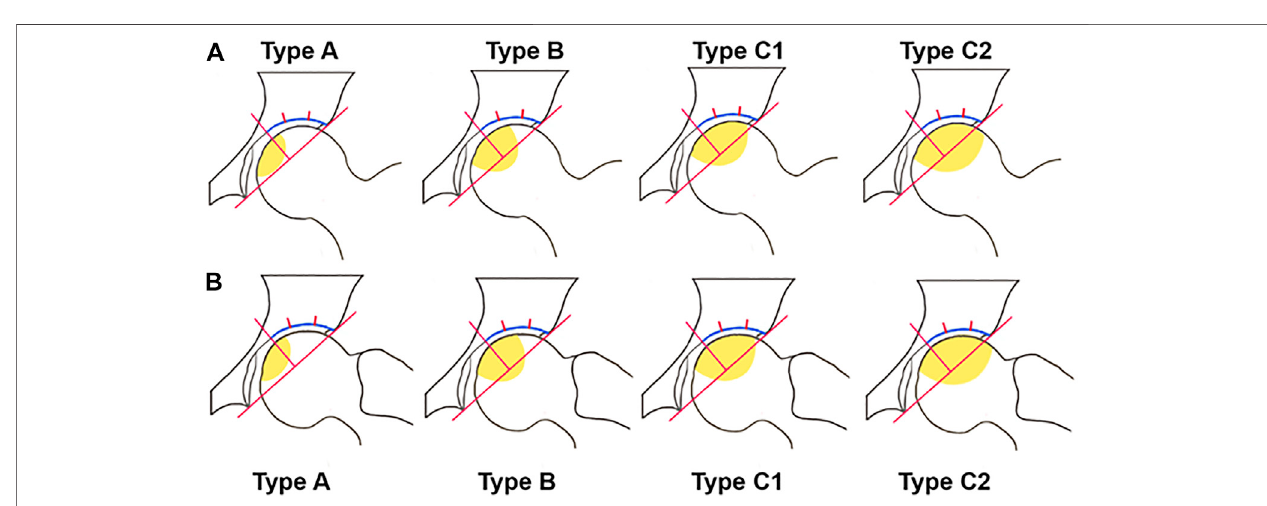
FIGURE 2 | JIC classi fi cation. (A) JIC classi fi cation in AP view. (B) JIC classi fi cation in FLL view. Type A: necrotic lesion involved the medial one-third or less of the weight-bearing portion; Type B: necrotic lesion occupies the medial two-thirds or less of the weight-bearing portion; Type C1: necrotic lesion occupies more than the medialtwo-thirdsoftheweight-bearingportionbutdoesnotextendlaterallytotheacetabularedge;TypeC2:necroticlesionoccupiesmorethanthemedialtwo-thirdsof the weight-bearing portion and extends laterally to the acetabular edge (Sugano et al., 2002; Wei et al., 2018; Wei QS. et al., 2019).